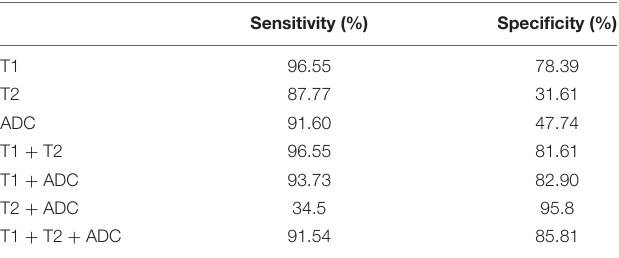
TABLE 6 | Sensitivity and specificity of each single parameter and combinations of multi-parameters.